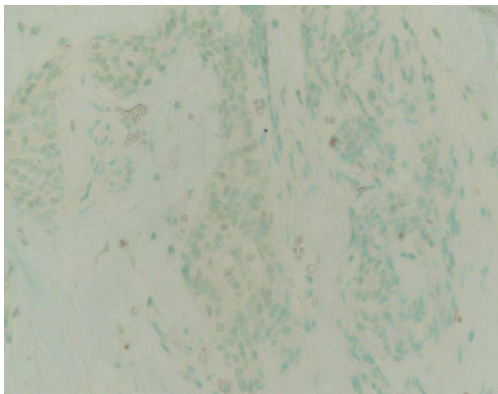
Figure 7: Showing low nuclear staining of p53 in CPA. Original magnification x40.